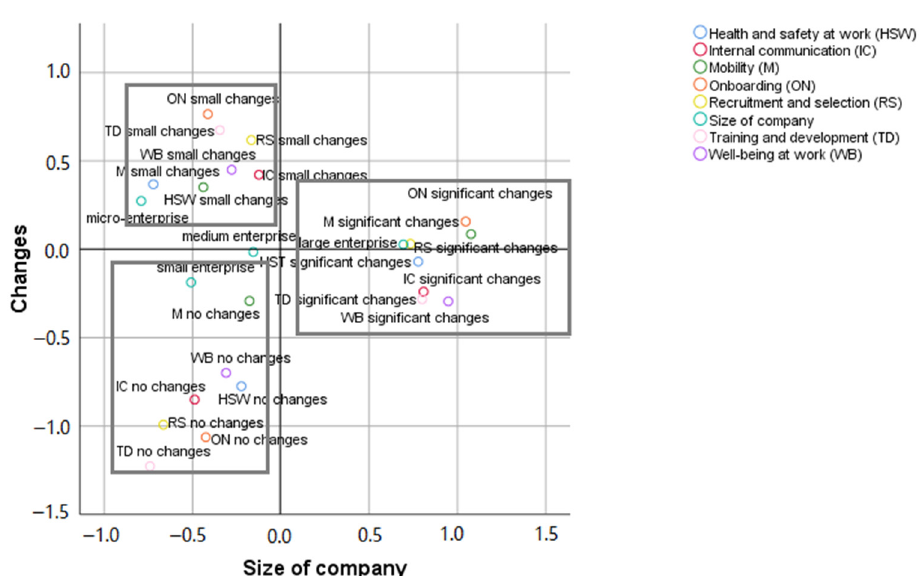
Figure 2. Changes in HRM practices and processes by company size.